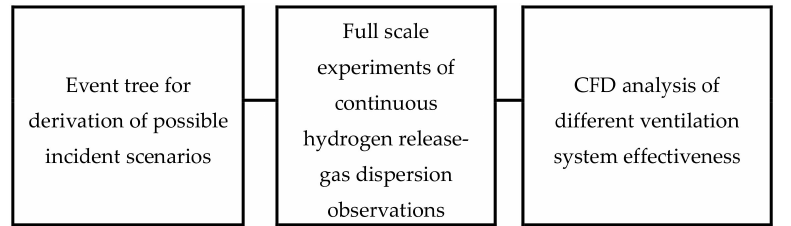
Figure 2. The analysis